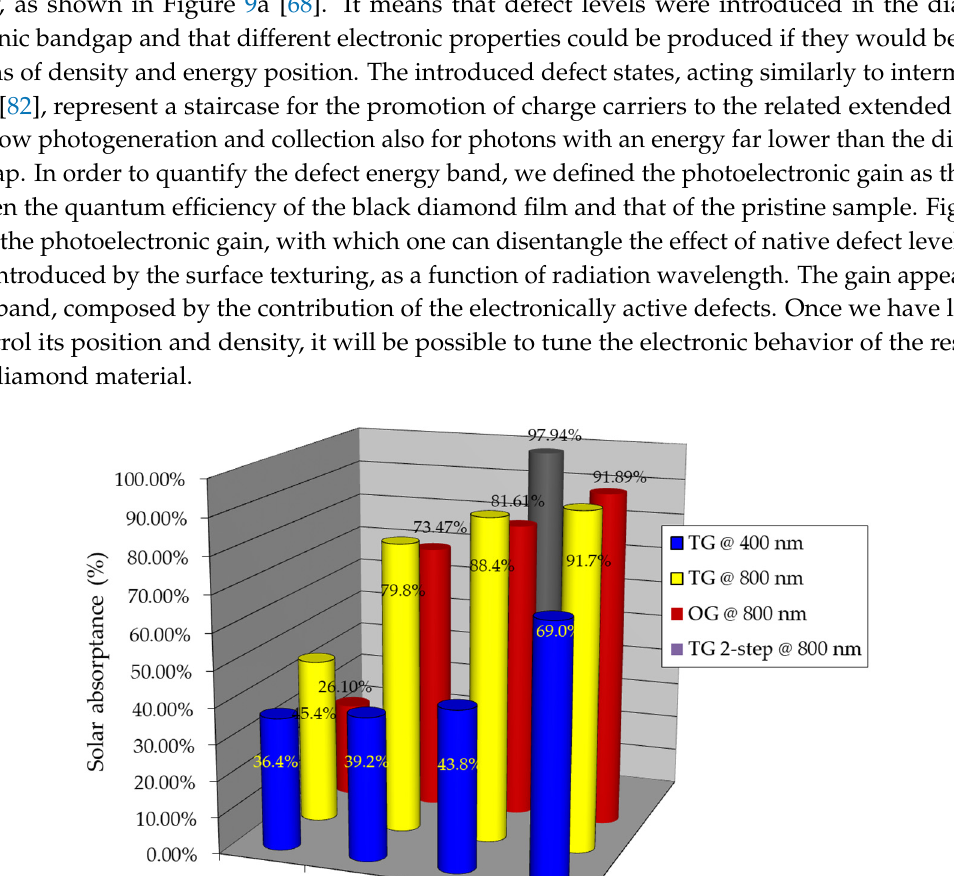
( b ) Figure 9. ( a ) Quantum efficiency as a function of radiation photon energy for a black diamond film and an untreated film [68] (CC BY 4.0). ( b ) Photoelectronic gain as a function of radiation wavelength for the optimally treated 1D ‐ periodic optical ‐ grade (OG, grey curve) and 2D ‐ periodic thermal grade (TG, black curve) samples. The photoelectronic gain represents the ratio between the quantum efficiency of the black diamond film and that of the pristine sample [83] (CC BY NC ND).